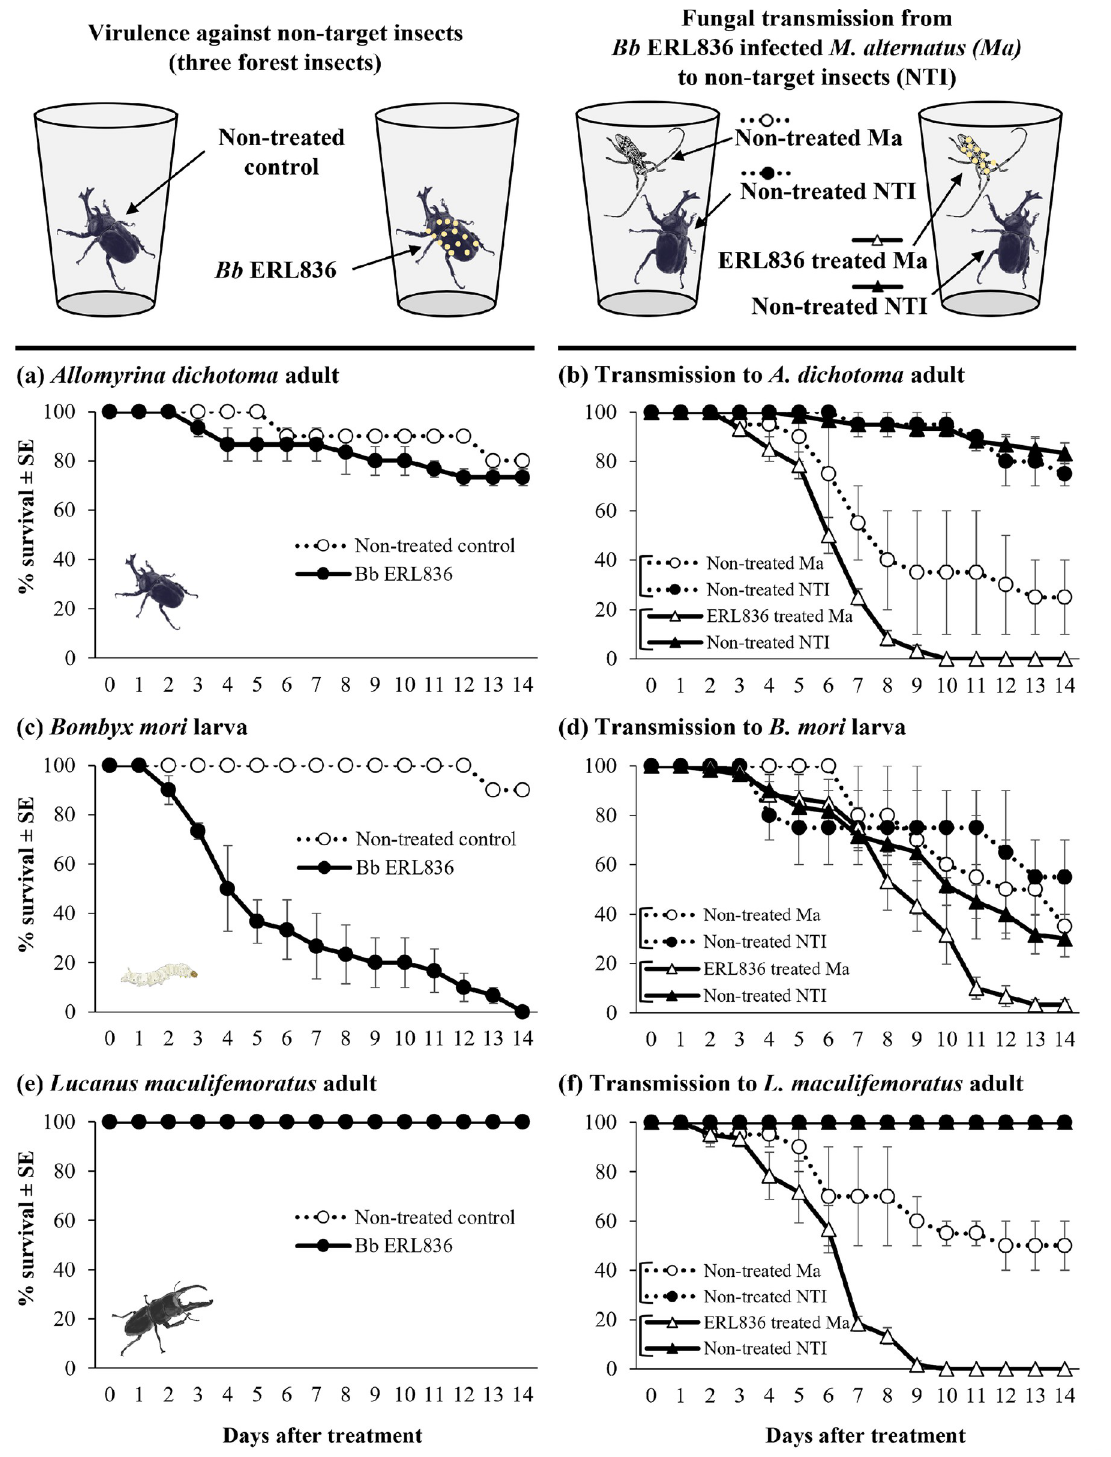
Fig 7. Transmission of B . bassiana ERL836 to non–target forest insects. To investigate the direct insecticidal activity, ERL836 conidia suspension at 1.0 × 10 7 conidia/ml was sprayed on three different non–target forest insects, A . dichotoma adults (a), B . mori larvae (c), and L . maculifemoratus adults (e) in plastic container conditions. Next to see the fungal transmission from infected M . alternatus adults to non–target insects, ERL836–sprayed M . alternatus adult was kept with a non–target insect, A . dichotoma adult (b), B . mori larvae (d), and L . maculifemoratus adults (f) in the same plastic container. Non–treated M . alternatus adult was kept with the same non–target insect as a control. Percent survival was analyzed daily for 14 days. https://doi.org/10.1371/journal.pone.0274086.g007 PLOS ONE | https://doi.org/10.1371/journal.pone.0274086 September 2,